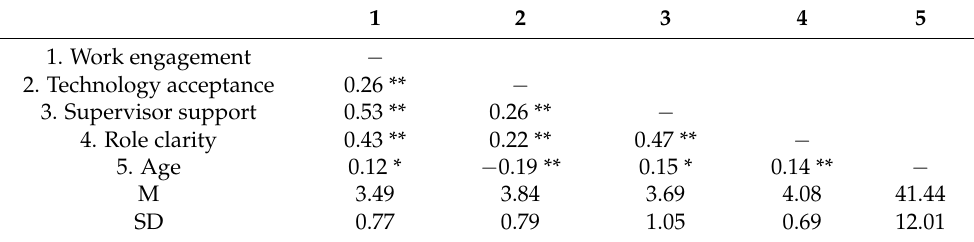
Table 1. Means, standard deviations, Cronbach’s alphas and correlations among study